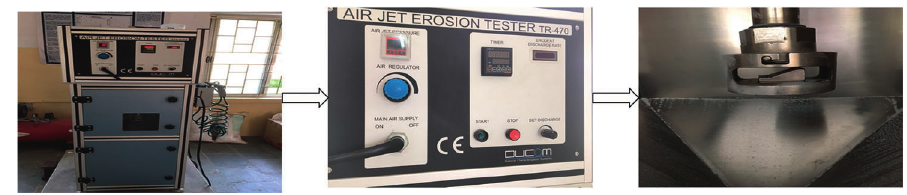
Figure 4: Air jet erosion test